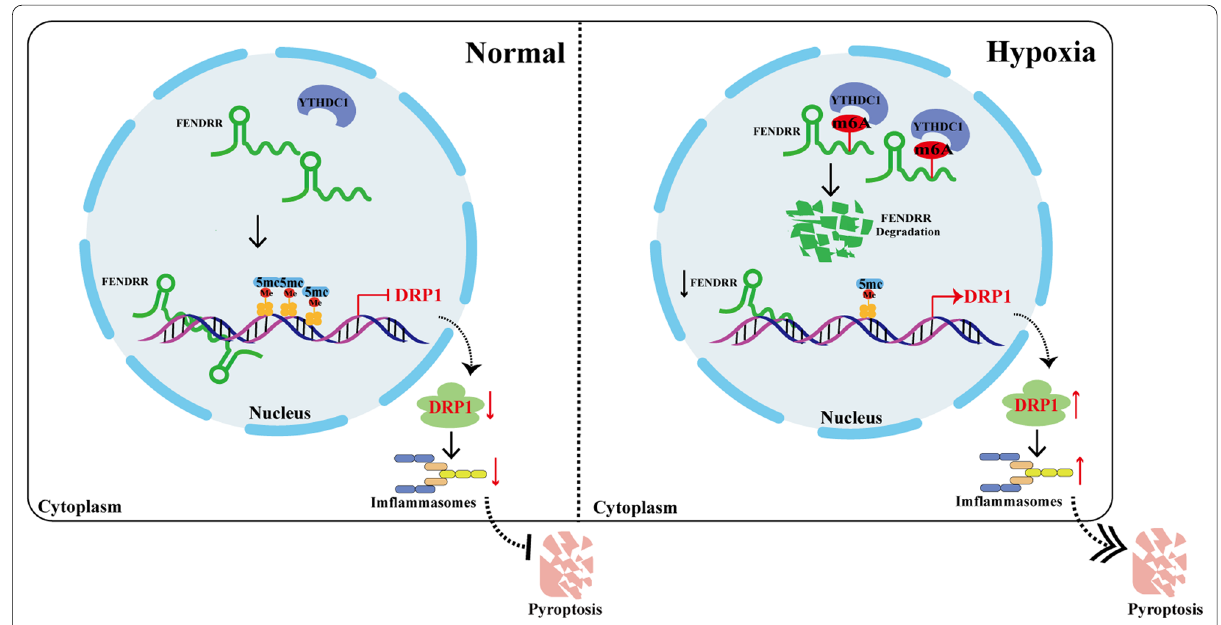
Fig. 8 A schematic diagram to illustrate the hypothetical